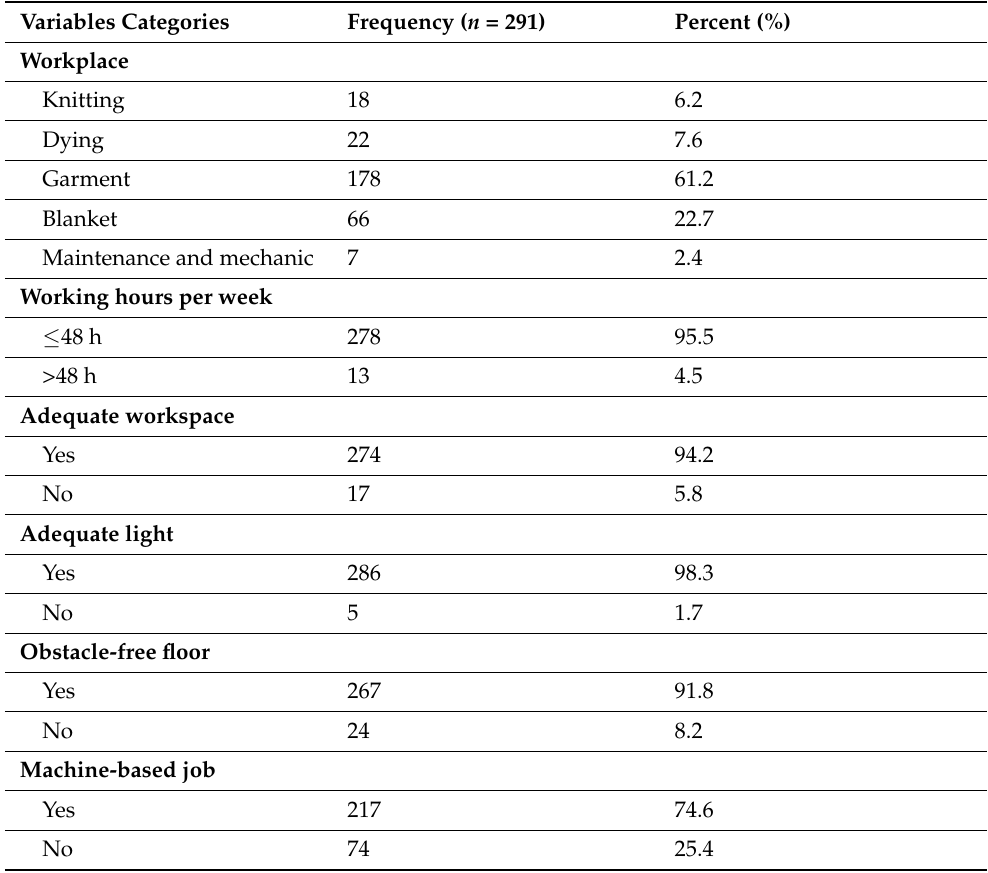
Table 3. Work environment characteristics of the integrated textile industry workers, Addis Ababa, Ethiopia,